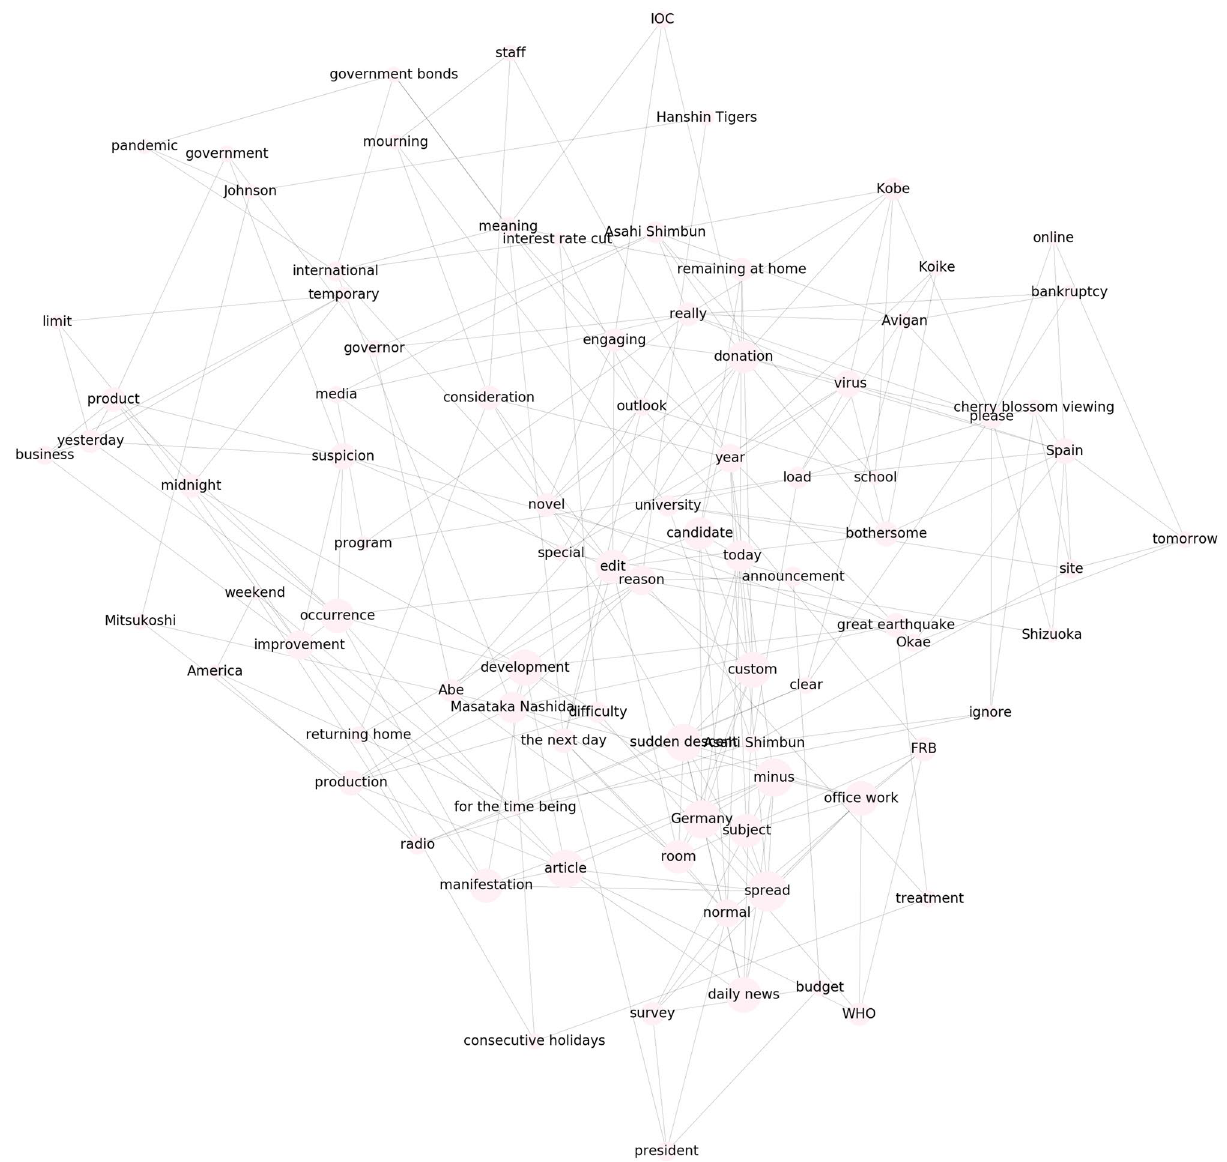
Figure 2. First trend cluster in Fig. 1a. Words corresponding to each trend are shown. For visualization, only 90 words in descending order of the degree to which each trend belongs to the cluster are